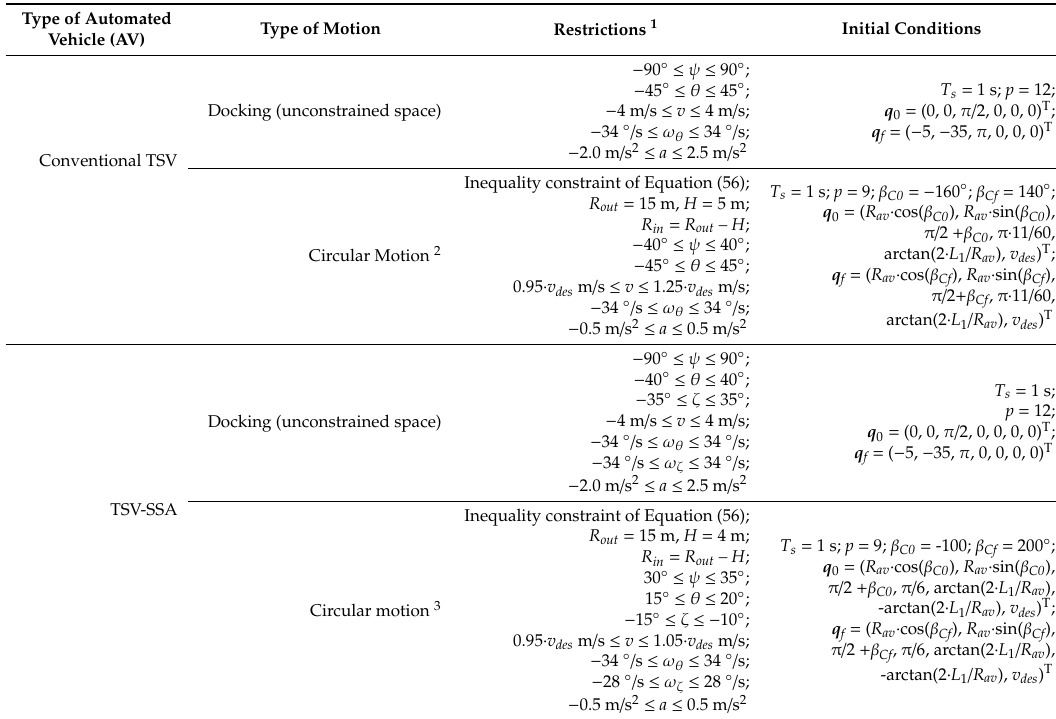
Table 3. Restrictions and initial conditions for simulating articulated